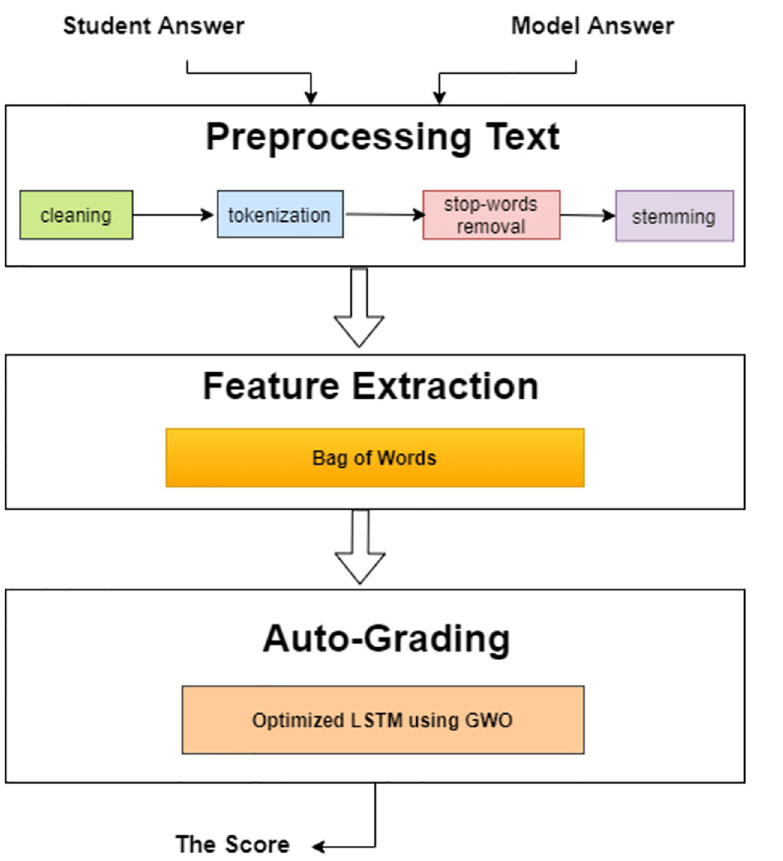
Fig 3. The proposed system block diagram for automatic grading of short